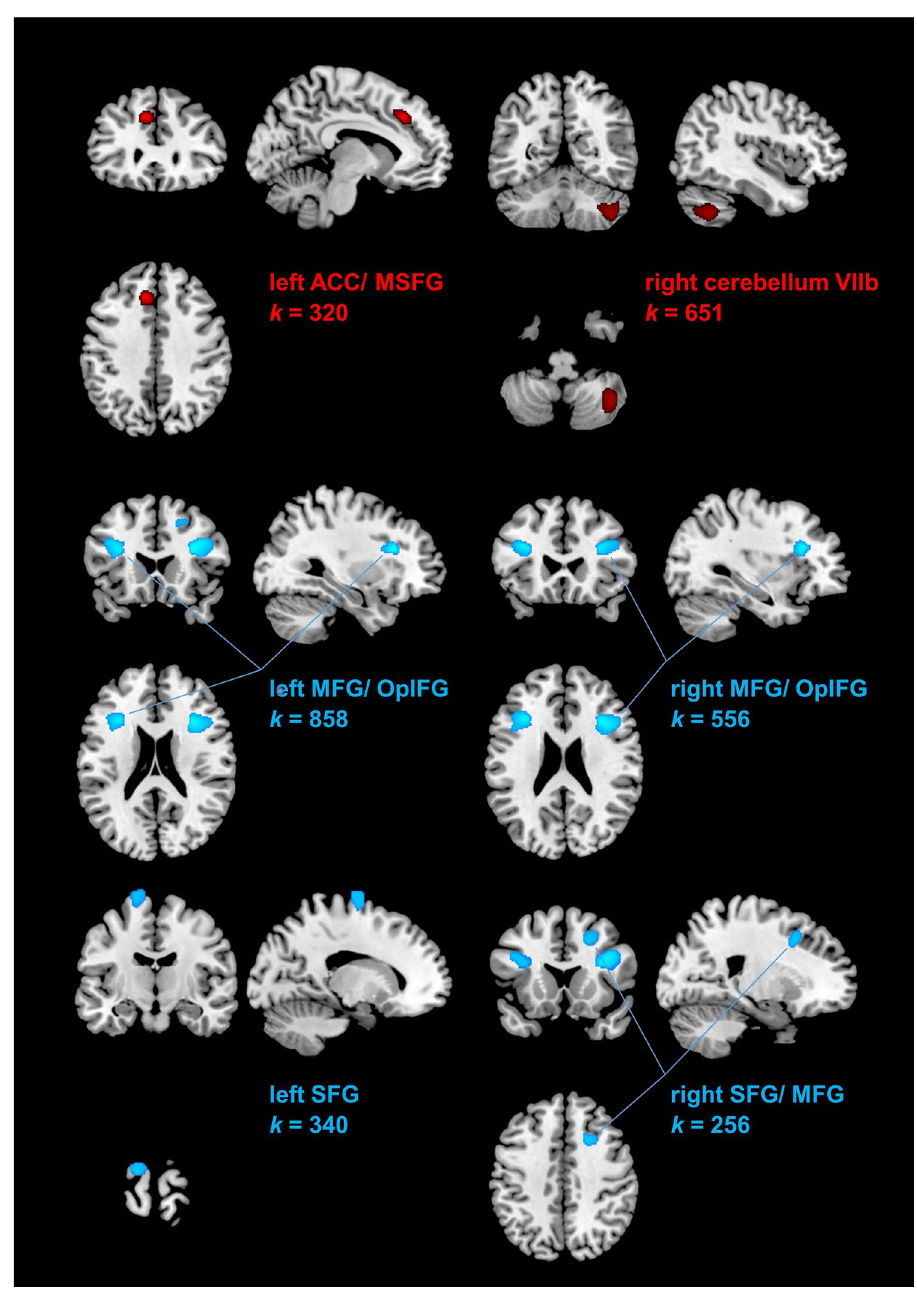
Figure 1. Graphical depiction of identified significant clusters in the VBM analysis of increases in rGMV (in red): in the left anterior cingulate cortex (ACC)/medial segment of superior frontal gyrus (MSFG) and in the right cerebellum VIIb/Crus II/Crus II, as well as decreases in rGMV (in blue): in the left and right middle frontal gyrus (MFG) adjacent to the opercular part of the inferior frontal gyrus (OpIFG), and in the left and right superior frontal gyrus (SFG), in ultrasound verum, relative to